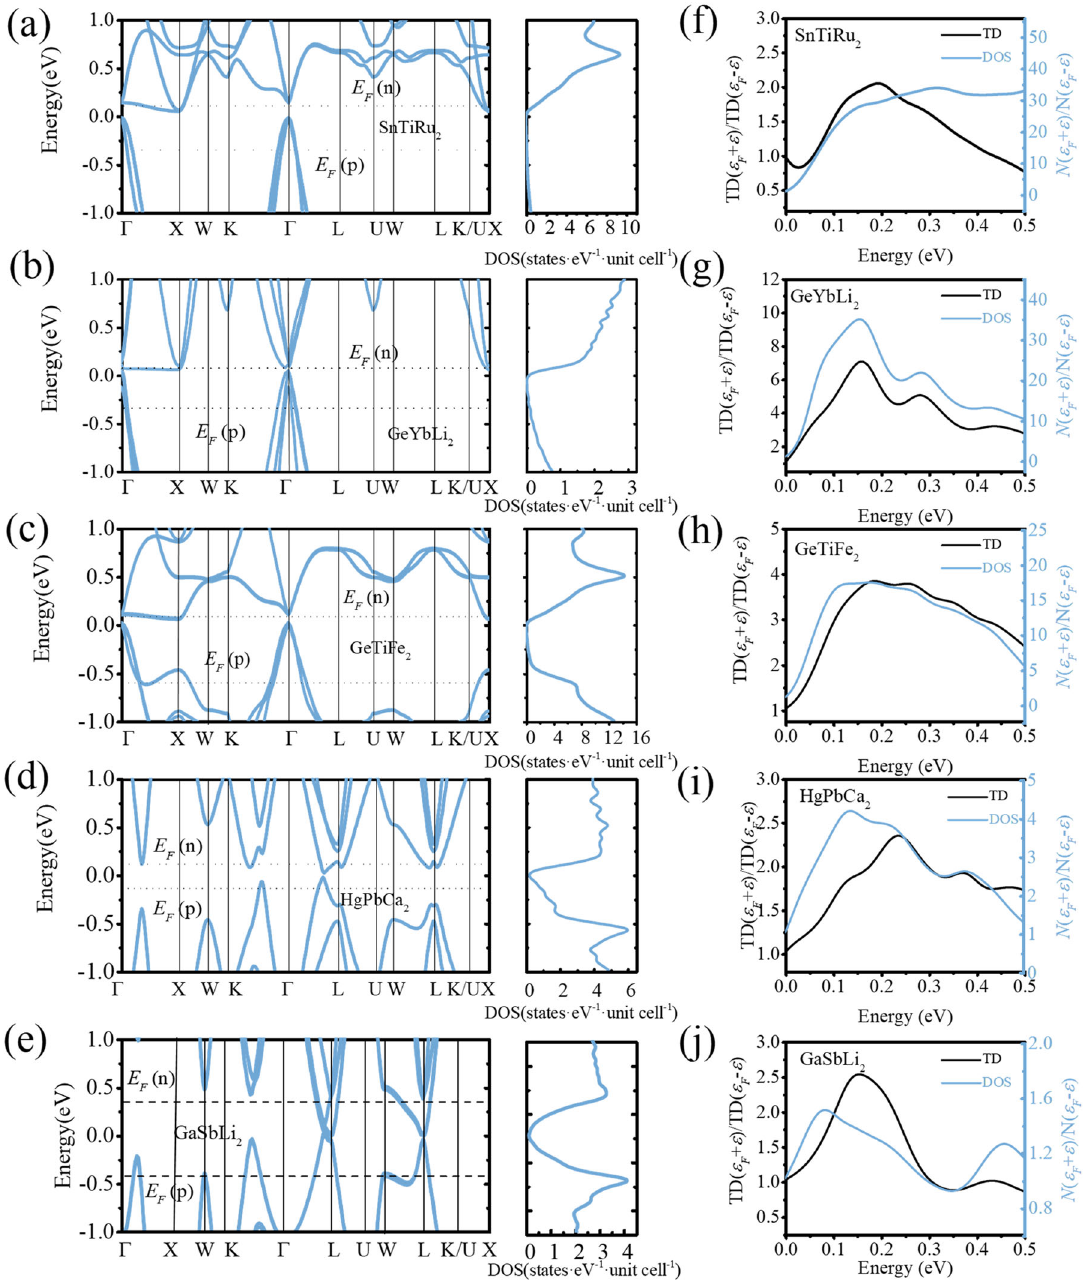
Fig. 4 Electronic structures of fi ve screened systems. The band structures and density of states for a SnTiRu 2 b GeYbLi 2 c GeTiFe 2 d HgPbCa 2 e GaSbLi 2 and the asymmetry ratio of TD and density of states DOS for f SnTiRu 2 g GeYbLi 2 h GeTiFe 2 i HgPbCa 2 j GaSbLi 2 , with ε F + ε and ε F - ε representing the physical quantities above and below the Fermi energy level, respectively. The dashed lines in each band structure represent the positions of the Fermi energy levels for both p-type and n-type PF max